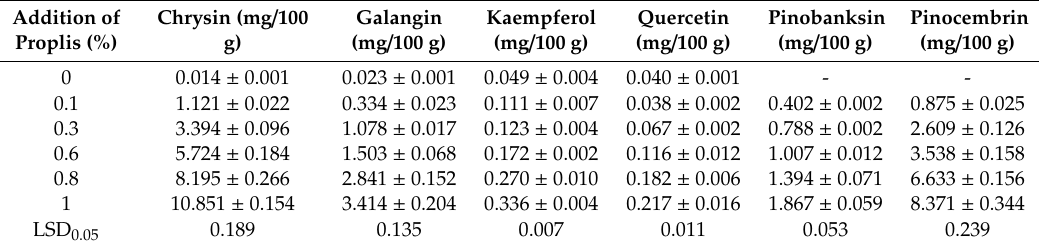
Table 2. The content of flavonoids in multifloral honey and honeys enriched with propolis. Addition of Chrysin (mg / Proplis (%)